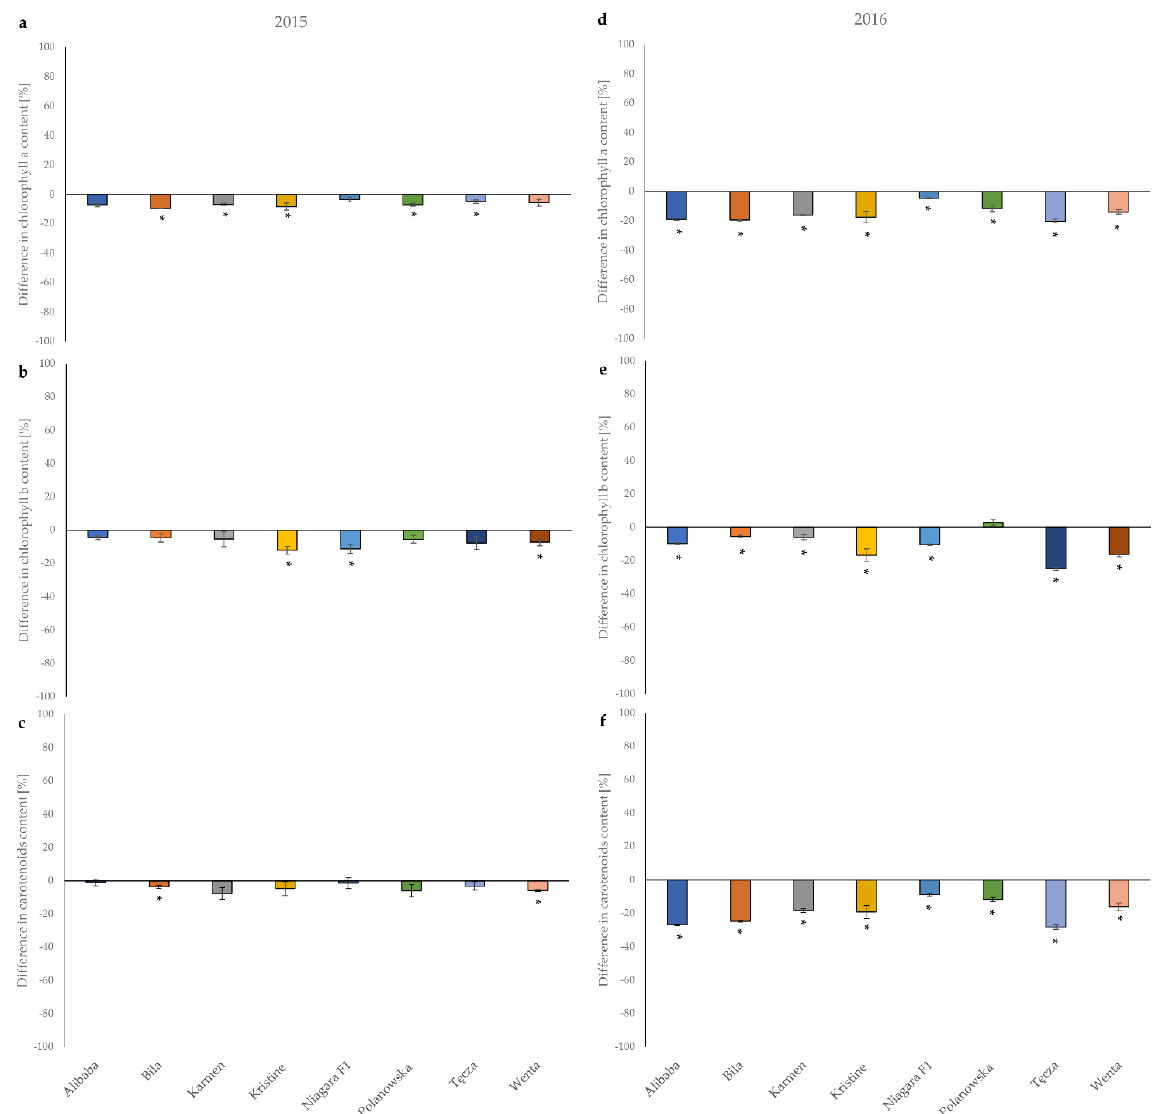
Figure 4. Effects of Thrips tabaci foraging on contents of ( a , d ) chlorophyll a, ( b , e ) chlorophyll b, and ( c , f ) carotenoids in the leaves of tested onion cultivars in 2015 and 2016. * significant differences between the control mean and the mean in colonized plants based on the Student’s t ‐ test conducted separately for each cultivar ( p < 0.05).